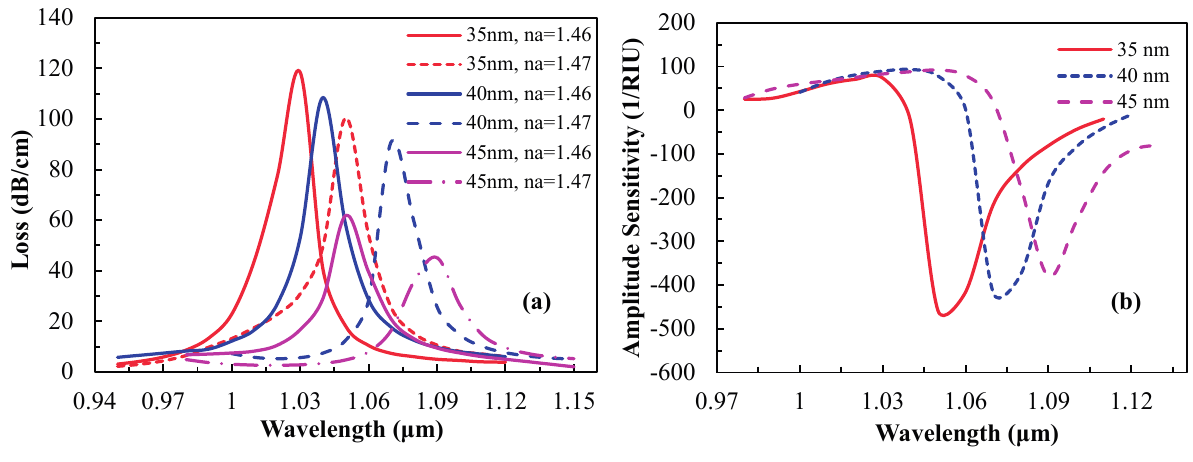
Figure 5. ( a ) Loss spectrum and ( b ) amplitude sensitivity vs. wavelength by varying silver thickness, setting analyte RI at n a =